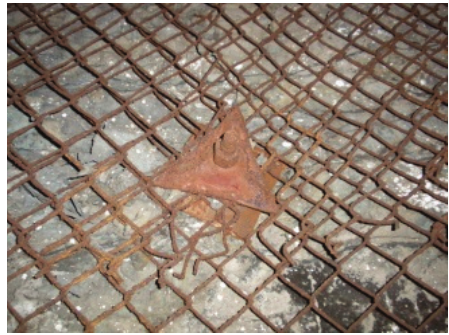
Fig. 5. Corroded parts of a rock bolt support in long-term excavation (photo by K.